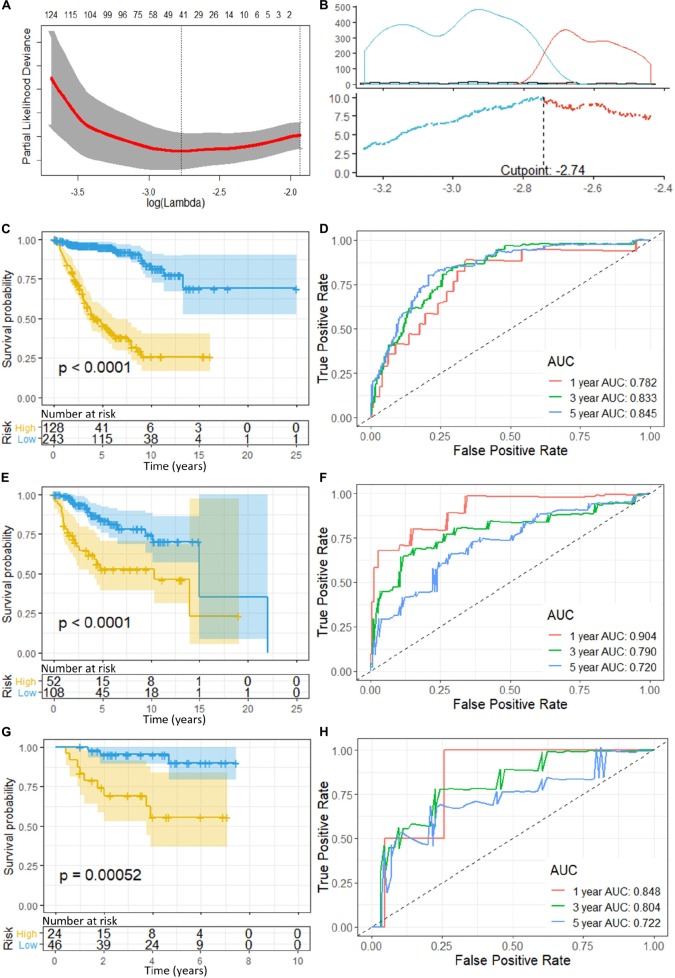
(A) Cross-validation of LASSO, the optimized log (lambda) was indicated by the dot line; (B) Optimizing the cutoff of the risk score using “maximally selected rank statistics method,” and an optimal cutoff of –2.74 was indicated; (C) K-M curve and (D) ROC of the training set; (E) K-M curve and (F) ROC of the validation set 1; and (G) K–M curve and (H) ROC of the validation set 2. P-value < 0.05 were considered statistically significant. Greater AUCs reflects better discrimination, while AUCs close to 0.5 reflects no discrimination. AUC, area under curve.